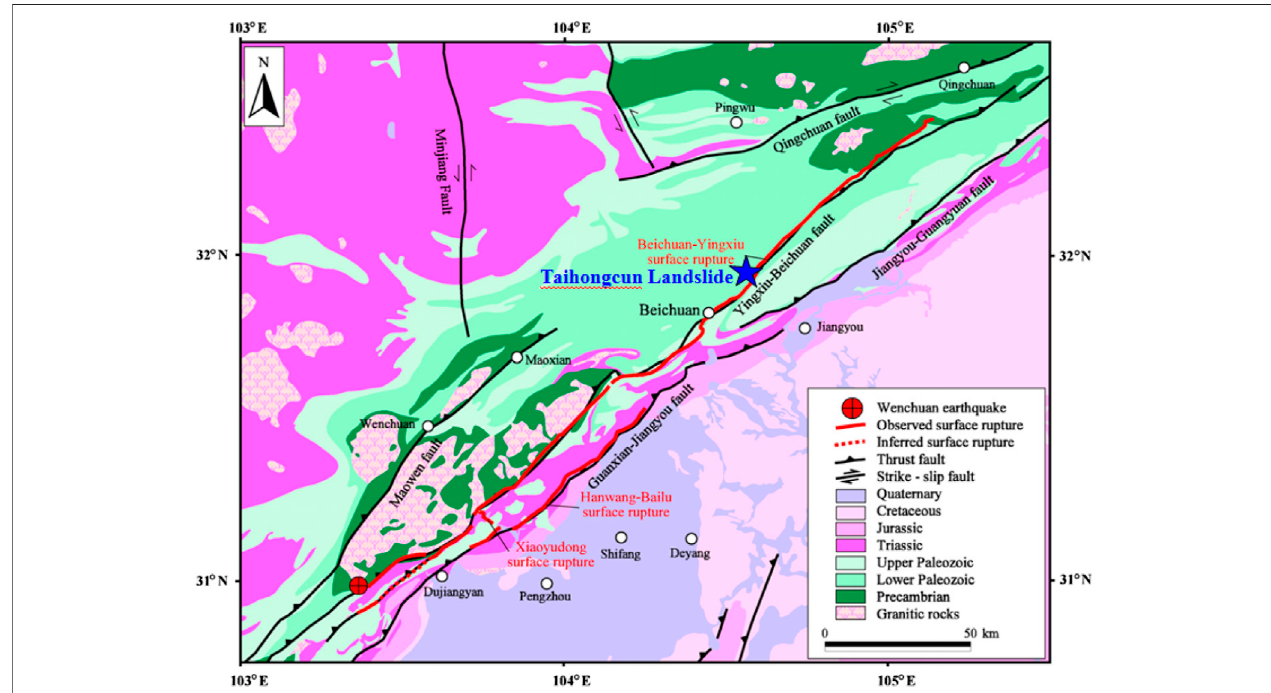
FIGURE 1 | Location of the Taihongcun landslide in Beichuan County, Sichuan Province (modi fi ed from Dai et al., 2011).